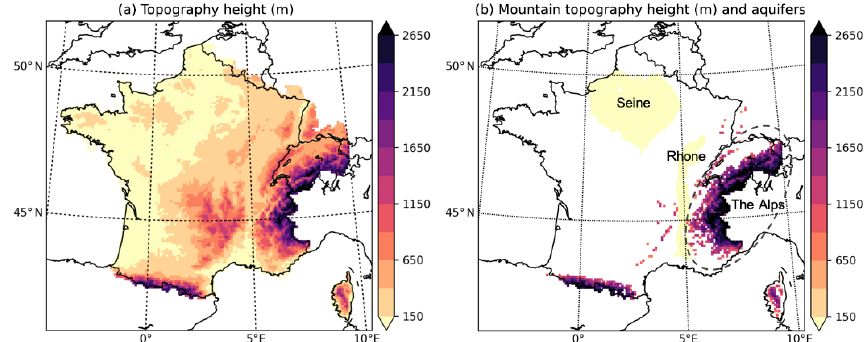
Figure 1. Height of the topography of the 9892 cells of the SIM grid (a) and the 3878 cells of the mountain SIM grid (b) . The cells of the mountain grid correspond to the 1044 points having an altitude greater than 500m and described vertically by several layers. Zones in yellow correspond to the Seine and Rhône aquifers. The dotted line delimits the